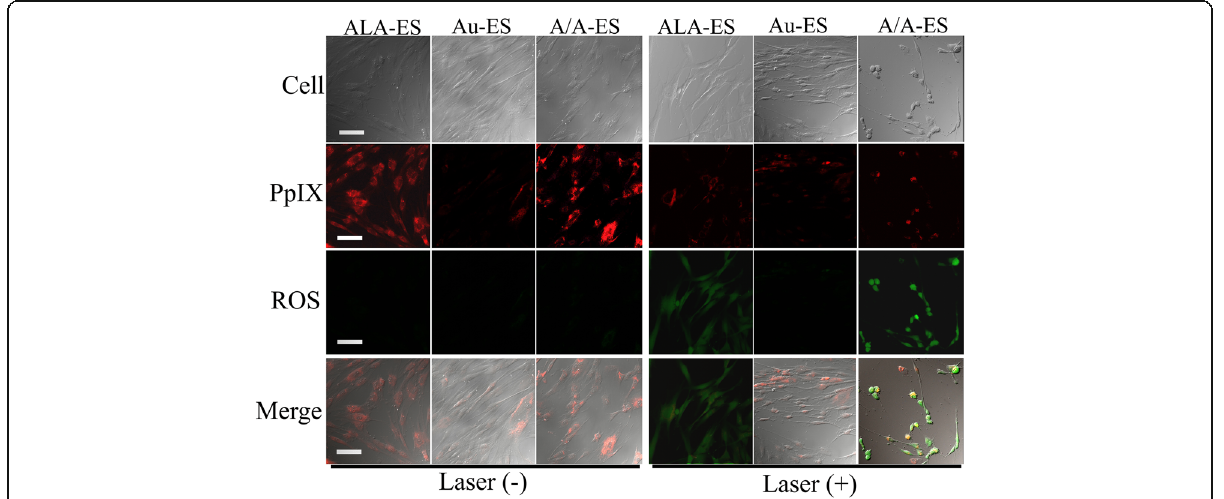
Fig. 4 Confocal images of HSF treated with ALA-ES, Au-ES, and A/A-ES for 6 h and followed without/with irradiations. The scale bar is 100 μ m